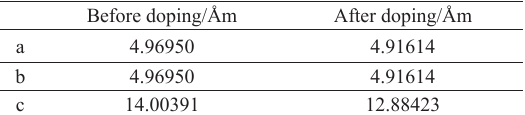
Table 1. The lattice parameters before and after doping (DFT calculation). Before doping/Åm